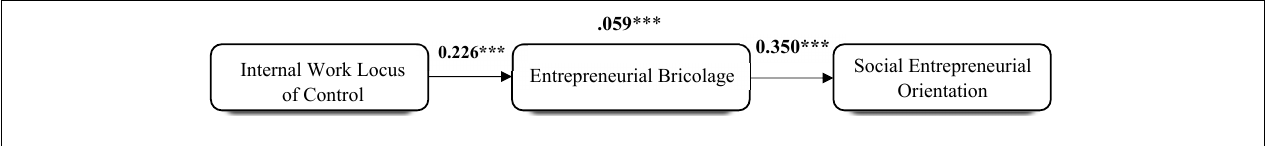
FIGURE 2 | Hypotheses testing estimates. ***indicates p <